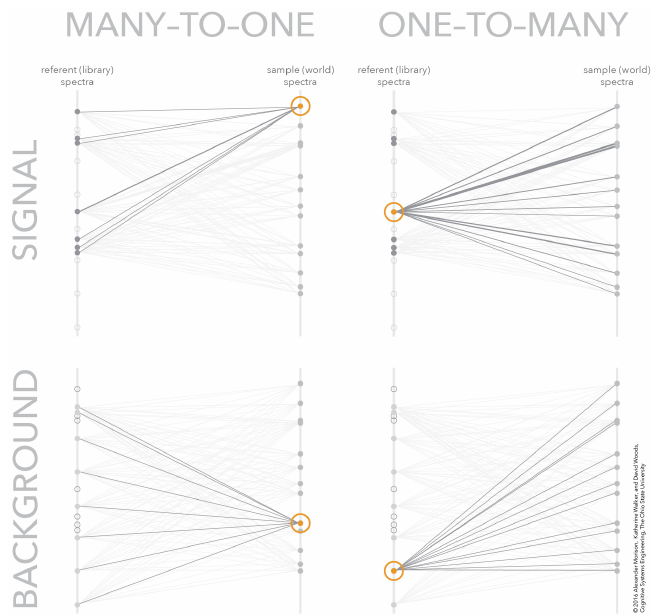
Figure 4. The many-to-many mapping decomposed into four one-to-many mappings. The one-to-many mappings are one sample to many signal referents ( upper-left ), one signal referent to many samples ( upper-right ), one sample to many background referents ( lower-left ), and one background referent to many samples ( lower-right ).